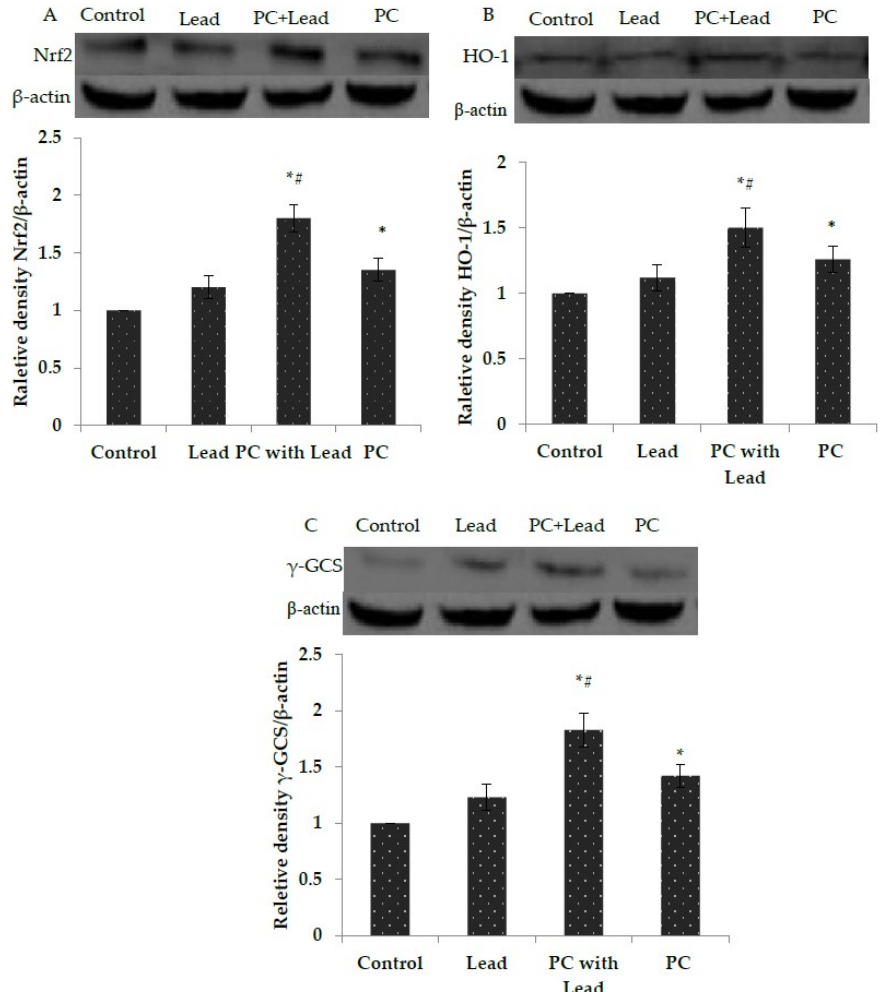
Figure 5. The effect of proanthocyanidins (PCs) on the protein expression levels of the nuclear Nrf2, HO-1, and γ -GCS protein in liver tissues of mice exposed to lead. ( A ) Nuclear erythroid 2-related factor 2 (Nrf2); ( B ) hemeoxygenase-1 (HO-1); and ( C ) γ -glutamyl cysteine synthetase ( γ -GCS). All results are expressed as the mean ± SE ( n = 7). * p < 0.05, significant change with respect to the control; # p < 0.05, significant change with respect to lead-treated